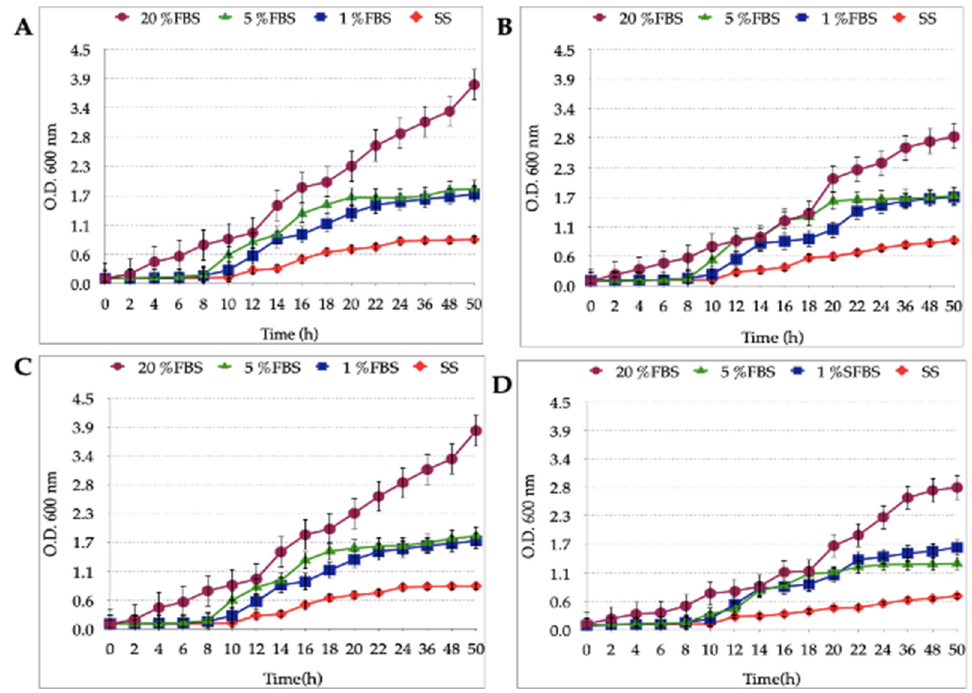
Figure 4. Candida growth curves in the presence of BB supplemented with 1%, 5% or 20% FBS or its absence. ( A ) C. albicans ATCC 90028; ( B ) C. glabrata ATCC 90030; ( C ) C. albicans VT-3; ( D ) C. glabrata LEO-37. The highest growth level was achieved using 20% FBS, followed by the cultures with 1% and 5% FBS. In the latter, there was no significant difference identified between these two growth curves p > 0.05; however, a highly significant difference was found between the growth curves in SS when compared with the other treatments p < 0.0001.